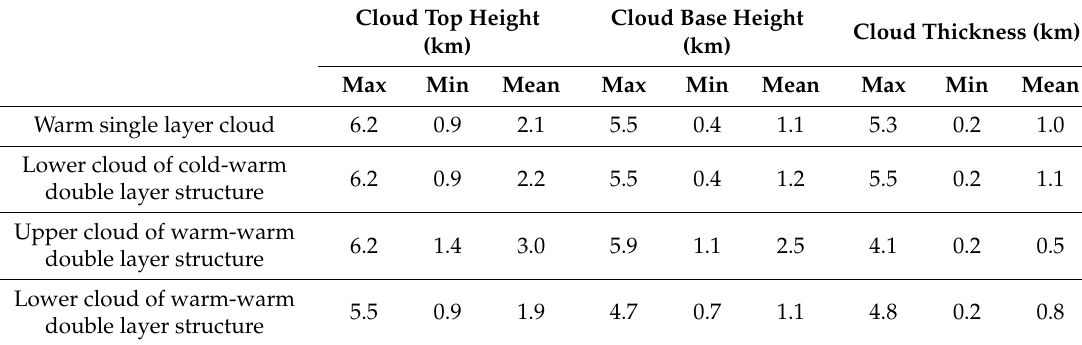
Table 1. Statistics of geometric features for the four kinds of warm cloud layer. Cloud Top Height Cloud Base (km)